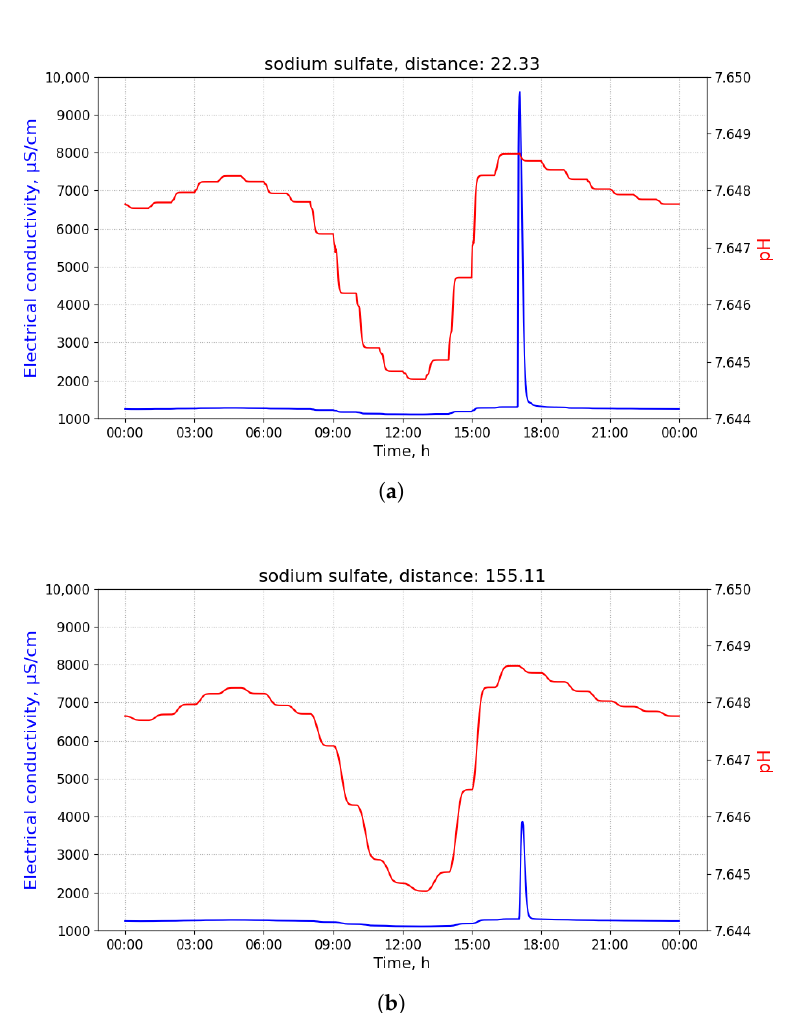
Figure 8. Measurements of pH and electrical conductivity (EC) for the utility network content contam- inated with sodium sulfate conducted at different distances. Values of the horizontal axis represent time of the day. ( a ) Measurements of pH and EC for the utility network content contaminated with sodium sulfate conducted at the distance of 22.33 m from the contamination source. Measured at the 02 manhole, discharged at the building B34 with 100 L of the pollutant at 8 am. ( b ) Measurements of pH and EC for the utility network content contaminated with sodium sulfate conducted at the distance of 155.11 m from the contamination source. Measured at the 20 manhole, discharged at the building B32 with 100 L of the pollutant at 8